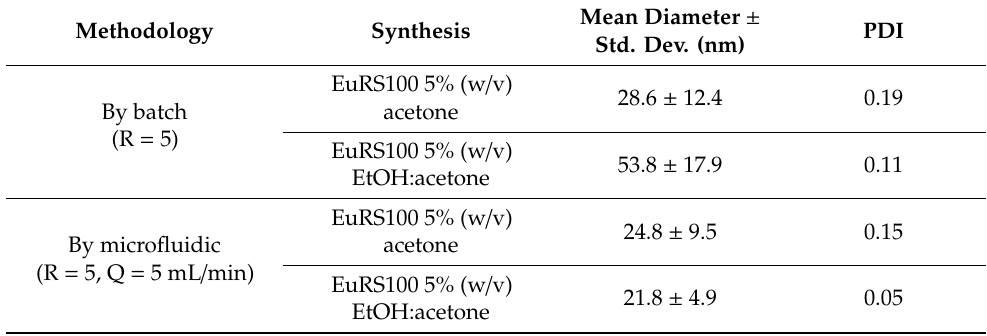
Table 6. Mean diameter and PDI comparison between batch and continuous flow production: e ff ect of type of solvent in the